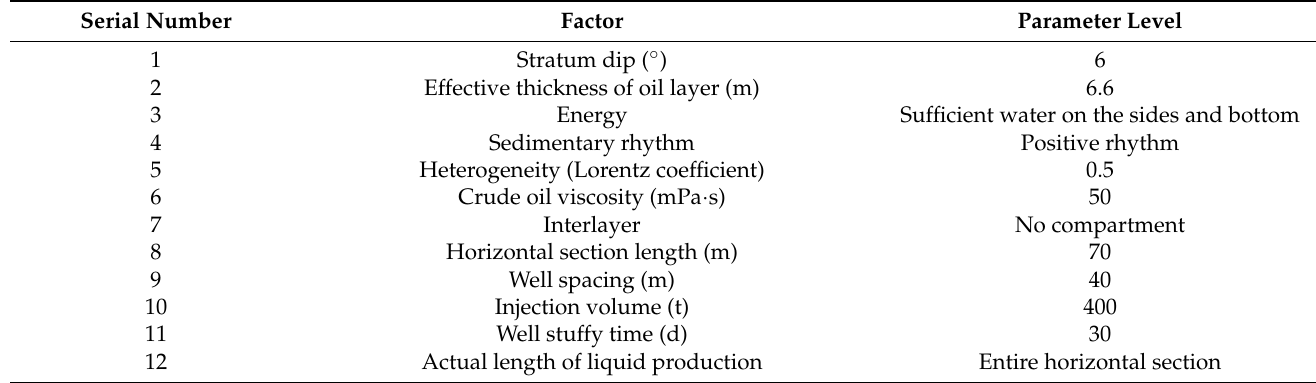
Table 3. Basic parameters of the typical numerical simulation